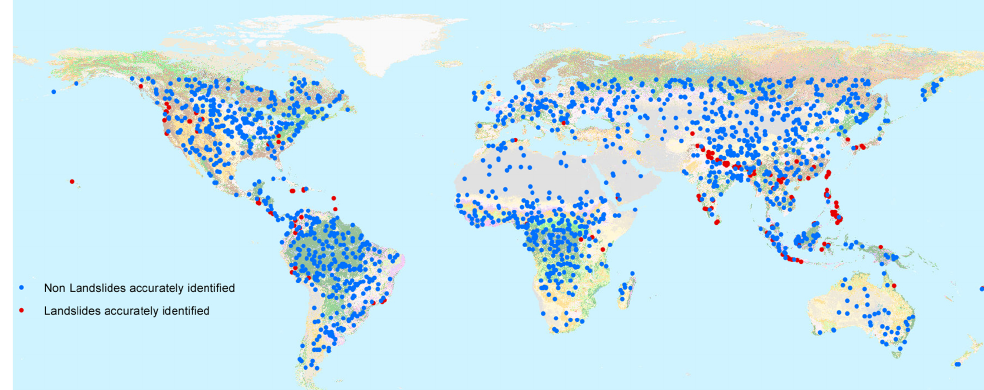
Fig. 8. An example of the SVM-based model output for one iteration. The red circles indicate landslides identified correctly, whereas blue circles show non-landslides identified correctly.